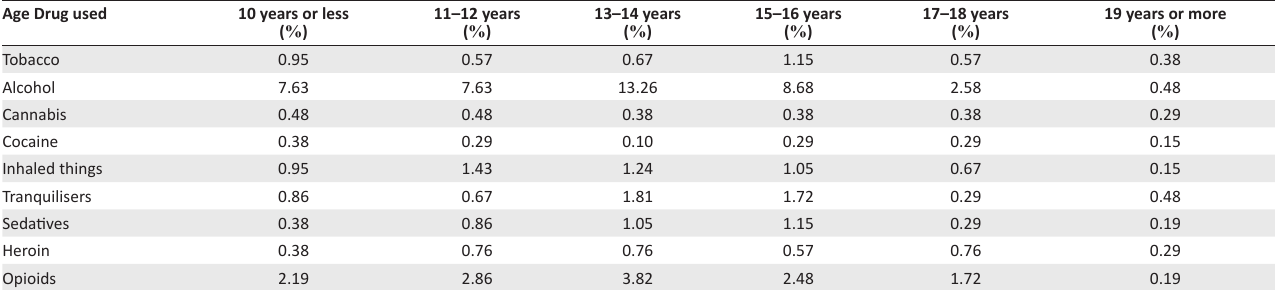
TABLE 3: Age at which secondary school students recollect using drug for the first time (non-medical). Age Drug used 10 years or less ( %